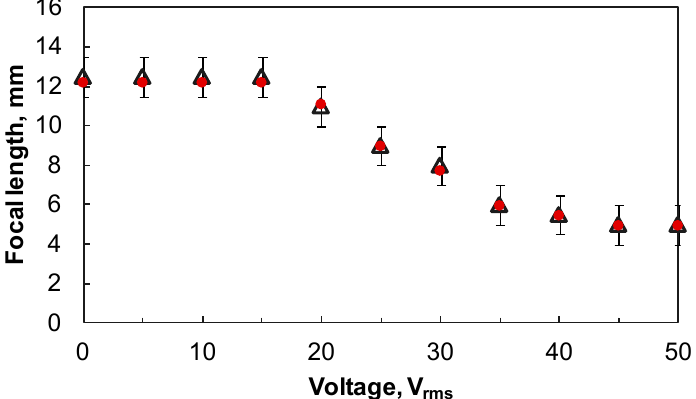
Figure 6. The measured focal length (triangles) and the calculated focal length (dots) of the liquid lens changed with voltages.